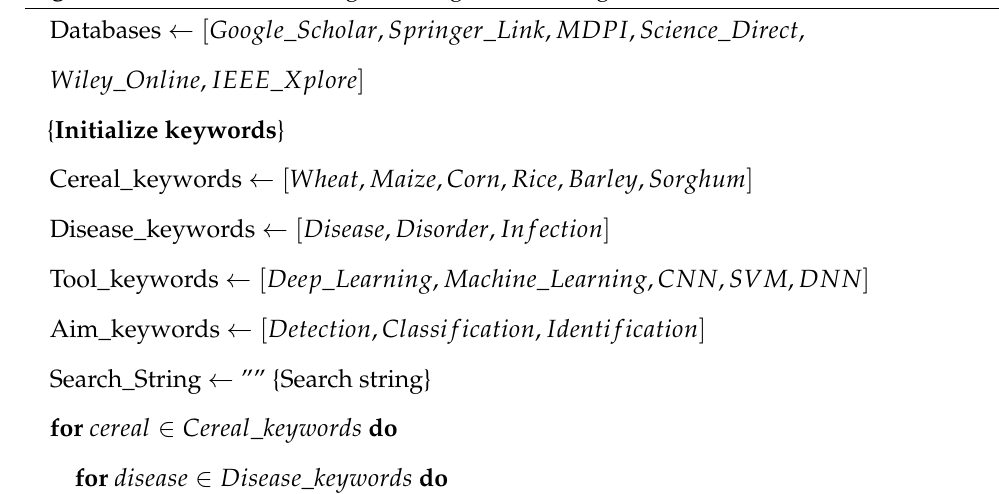
Algorithm 1 Pseudocode for generating search